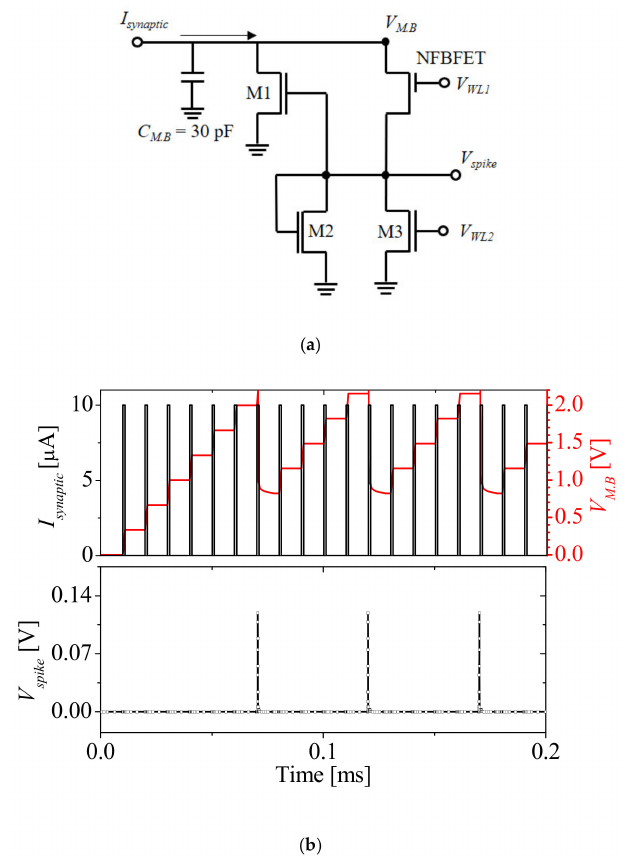
Figure 8. Circuit diagram of ( a ) an integrate and fire circuit for spiking neural network (SNN) and ( b ) synaptic current, membrane voltage, and spike